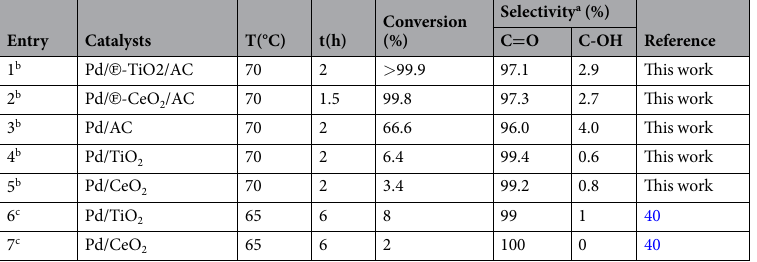
Table 4. Catalytic results for Pd/ Ⓕ -MeO x /AC, Pd/AC and Pd/MeO x catalysts. a C = O indicates cyclohexanone and C-OH indicates cyclohexanol. b Reaction conditions: phenol (0.353 g, 3.75 mmol), Pd (0.5 mol % relative to phenol), dichlomethane (20 mL), P H2 (5 bar). c Reaction conditions: phenol 0.585 mmol, Pd (4 mol% relative